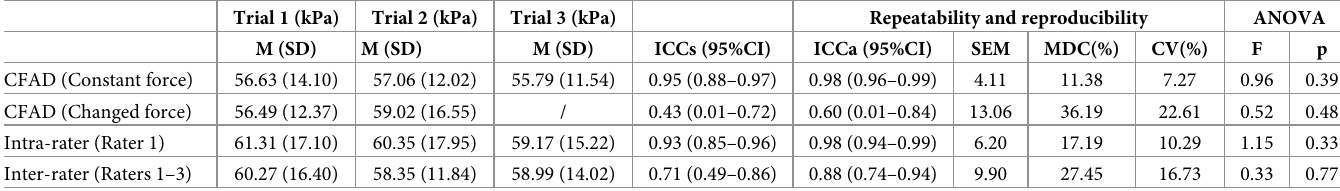
Table 2. Repeatability and reproducibility results for measurements on meat specimens.